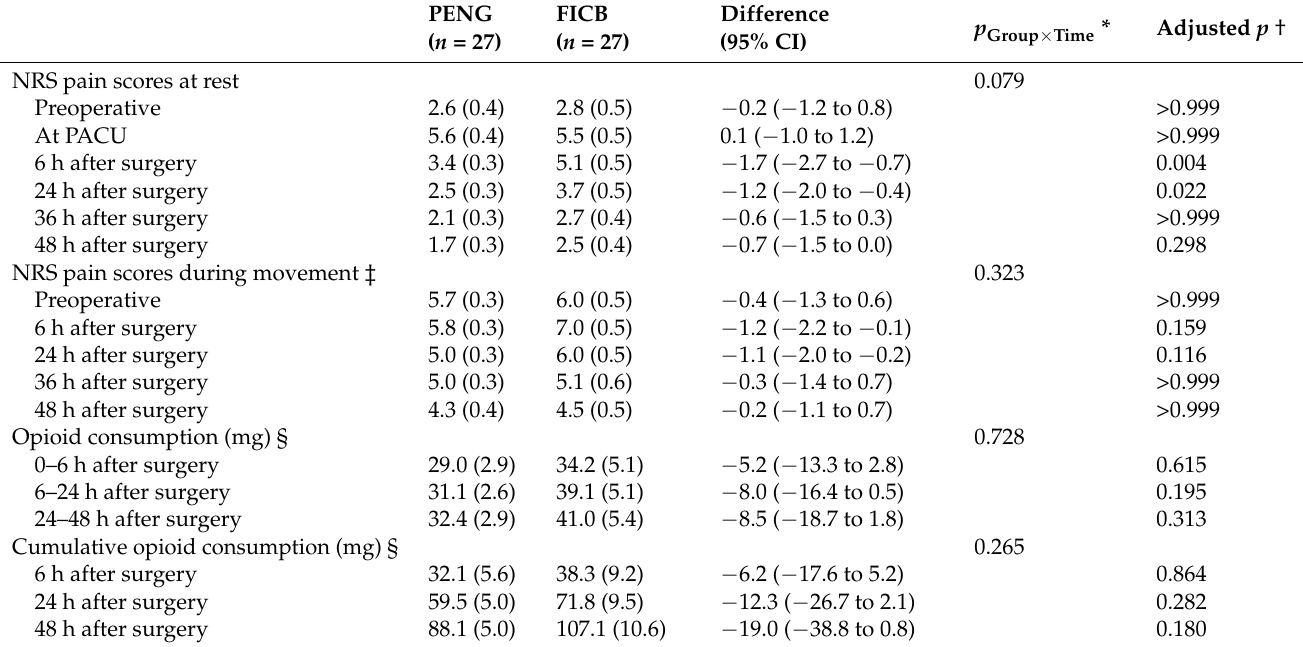
Table 2. Postoperative pain scores and opioid consumption.